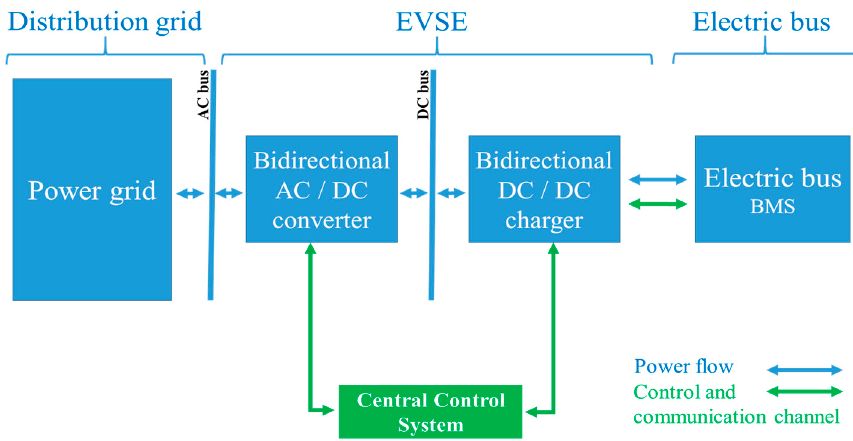
Figure 1. System architecture of the EVSE.